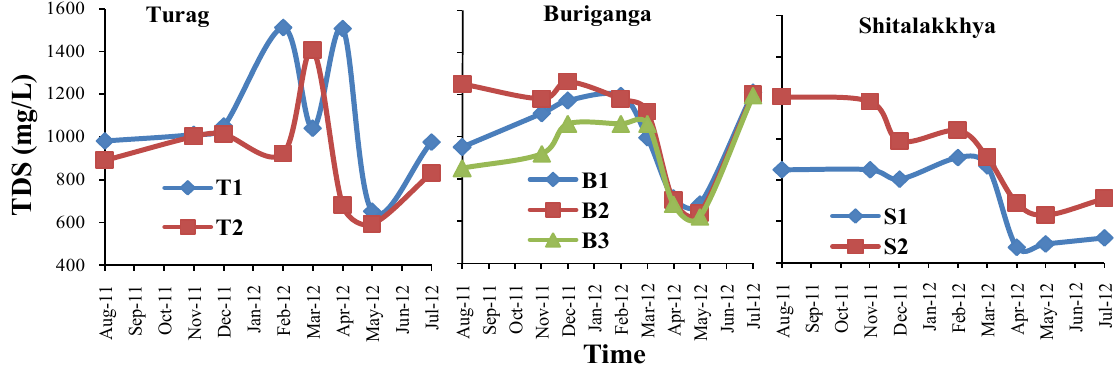
Figure 6. The total dissolved solids (TDS) values of the samples from the water of three different rivers around Dhaka